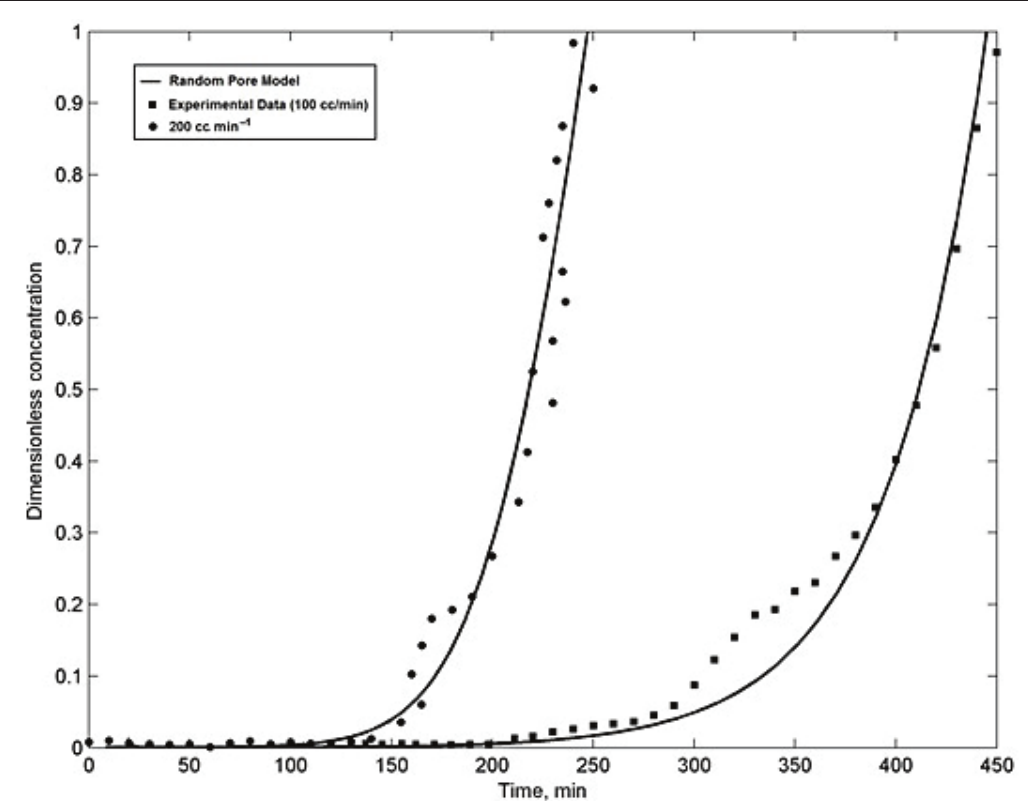
Fig. 5 – Comparison between random pore model predictions and experimental SO at 600 °C, 1 vol.% SO concentration, and various zero-air flow rates 2